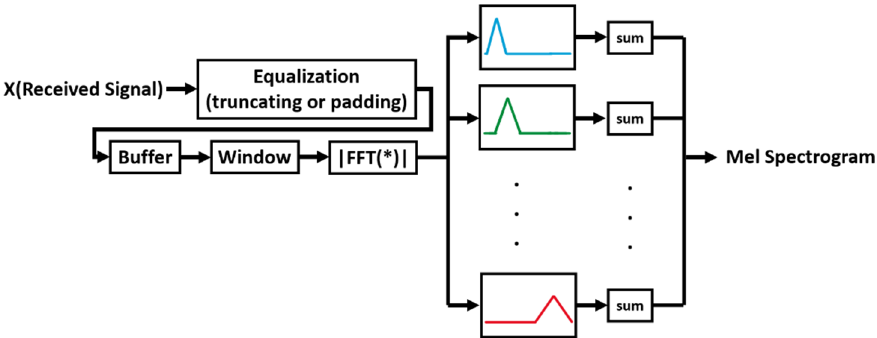
Figure 2. Equalizing and extracting Mel-spectrogram of the acoustic input signals. FFT(*) is the frequency-domain representation of the input * using FFT. Mel Filter Bank is represented by band-pass filters with different colors for better visibility.